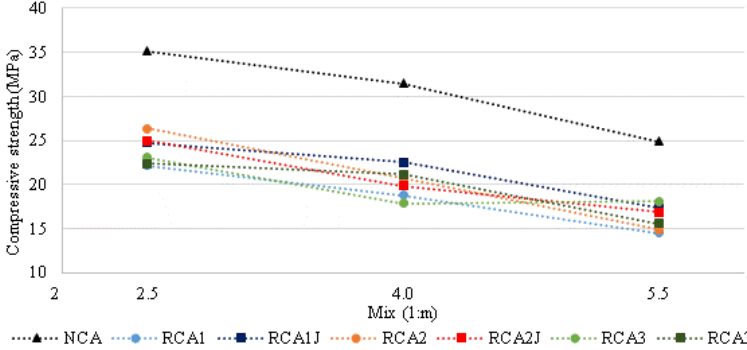
Figure 8. Influence of the mix on the axial compressive strength at 28 days